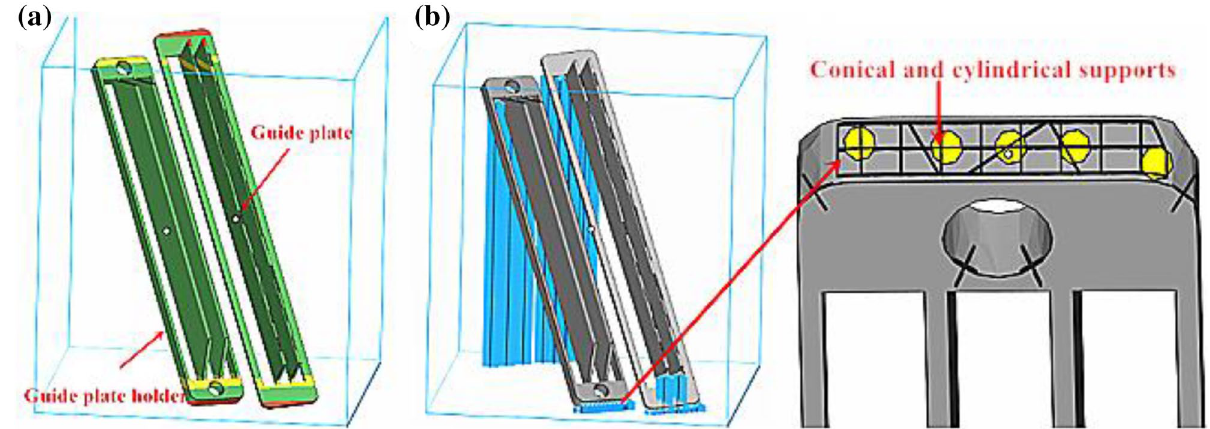
Figure 9. Processing technology of SLM formed curved deflector: ( a ) processing risk analysis; ( b ) Placement and support addition.